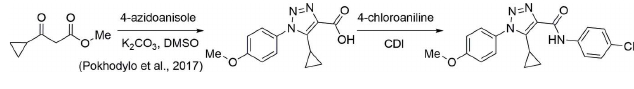
Figure 6 Synthesis of N- (4-chlorophenyl)-5-cyclopropyl-1-(4-methoxyphenyl)-1 H-